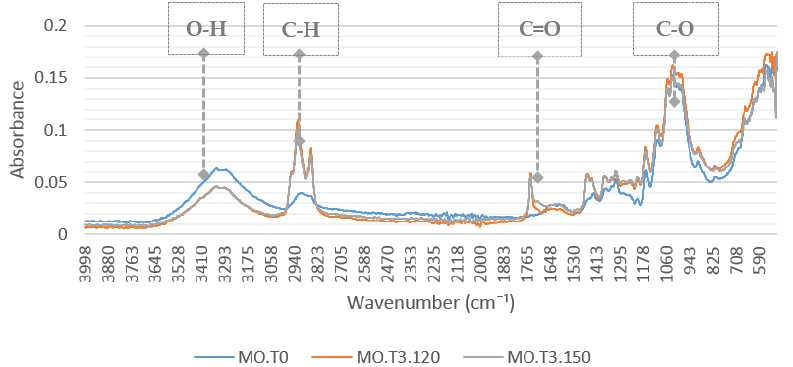
Figure 2. FTIR spectra of transformer paper aged in mineral oil at aging temperatures of 120 °C and 150 °C for 1008 h.